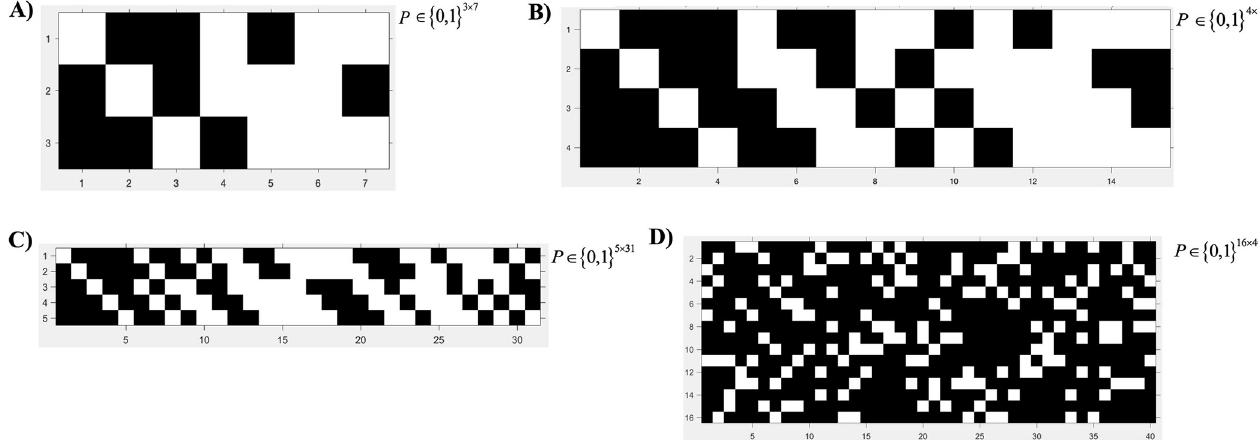
Fig 2. Optimized group testing mixing matrix design. (A-C) Hamming code parity check pooling matrix design for N = 7, 15, and 31. (A) N = 7 numerical matrix with 3 pools (3x7). (B) N = 15 numerical matrix with 4 pools (4x15). (C) N = 31 pixel matrix with 5 pools (5x31). (D) Bipartite pooling matrix design optimized for high N and prevalence rates. N = 40 pixel matrix with 16 pools (16x40). (A,B,C,D) White pixel indicates a sample included in the pool. Black pixel indicates a sample not included in pool.